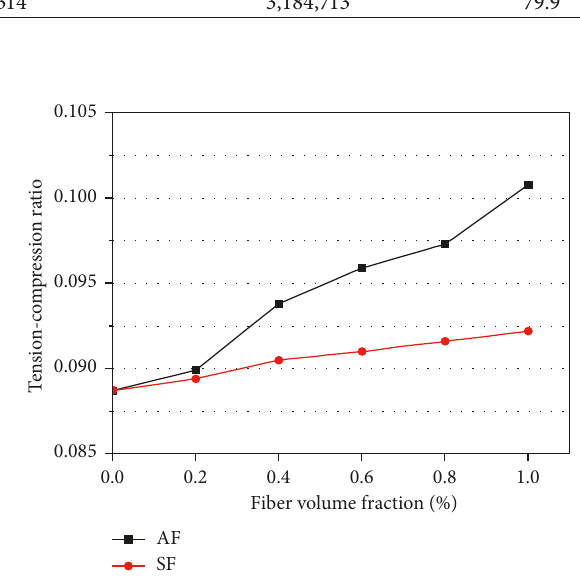
Figure 3: Tension-compression ratio of FRC.